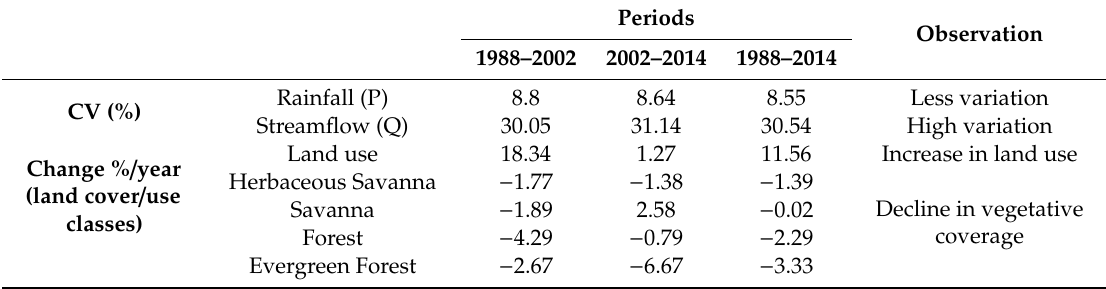
Table 4. Incidence of land use / cover change on streamflow at Kossou station (1981–2014).